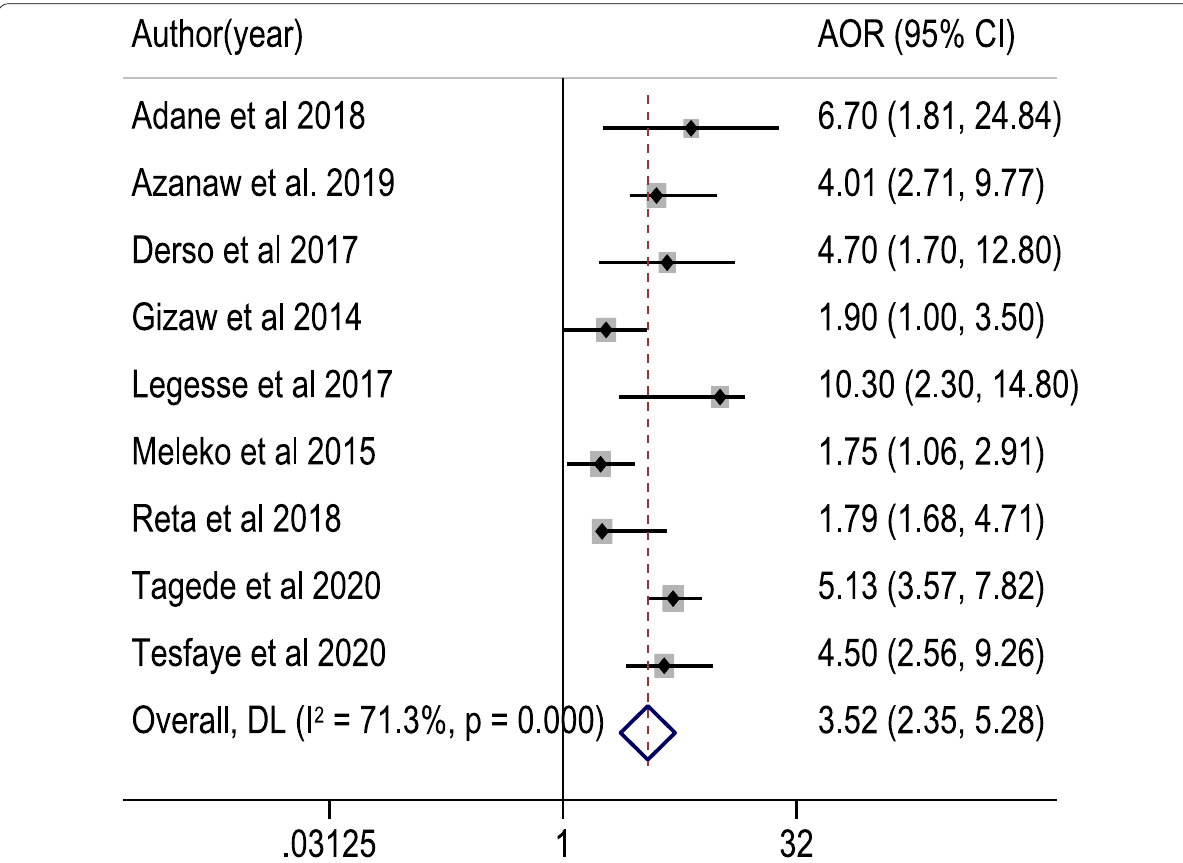
Fig. 7 The pooled adjusted odds ratio of the association between training of food handlers and food hygiene practice in